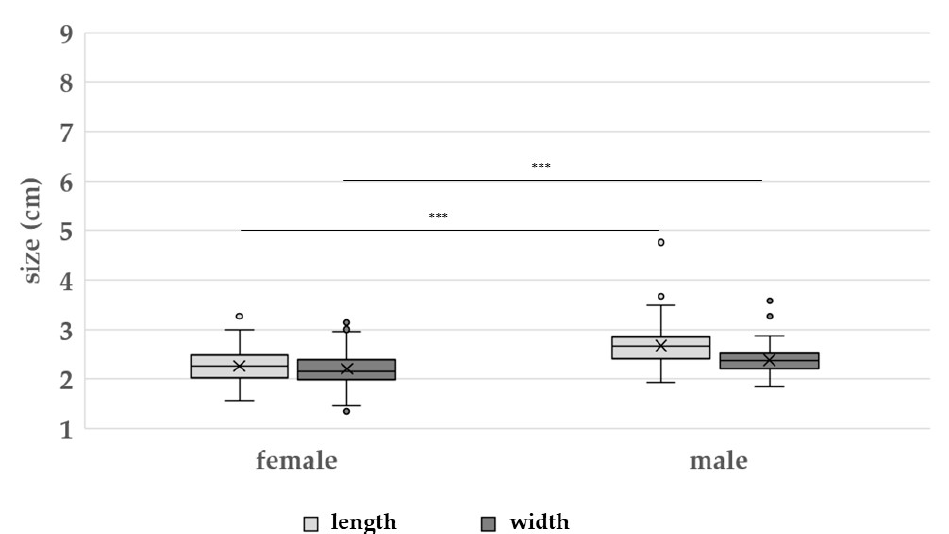
Figure 4. The lengths and widths (cm) of female and male broiler breeder foot pads ( n = 656). Results are presented as boxplots (data range, median, lower quartile and upper quartile; outliers are included in the graph as dots and means as crosses). ***= p < 0.05